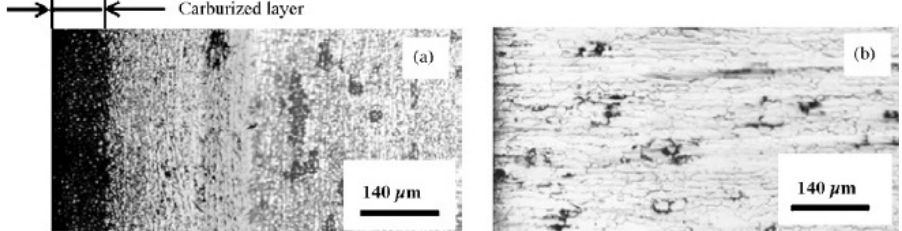
Figure 6. Micrograph of the vertical cross-section of compression side faces of non-superplastic SPDSS ( a ) and non-superplastic DSS ( b ) carburized at 1273 K for 30 min [12]. The surfaces are electrolytically etched using a 10% oxalic acid solution.